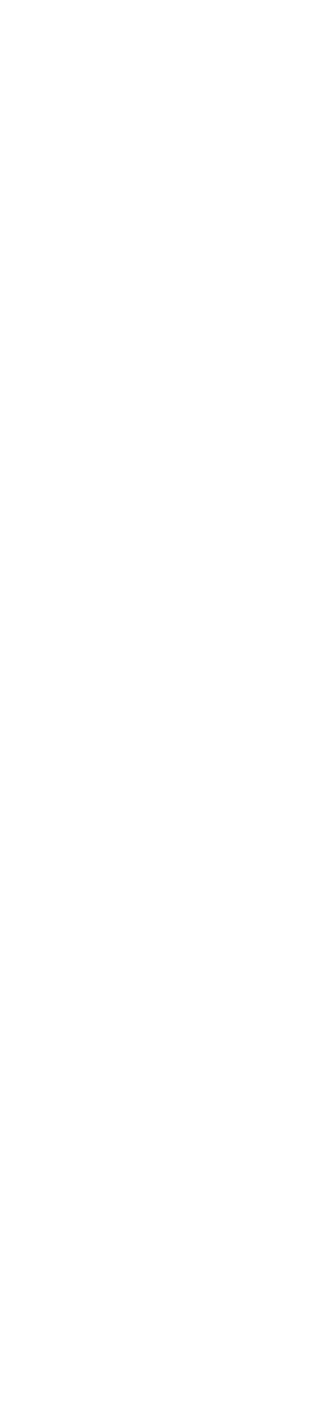
density estimate ~0.45, and 7 ‰ with highest kernel density estimate 0.4) and temperature (peaks at 4-5°C with highest kernel density estimate ~0.2, and a shoulder at 2.5°C with kernel density estimate 0.12-0.15) (Figure 9B). H. arctica subsp. frigida most